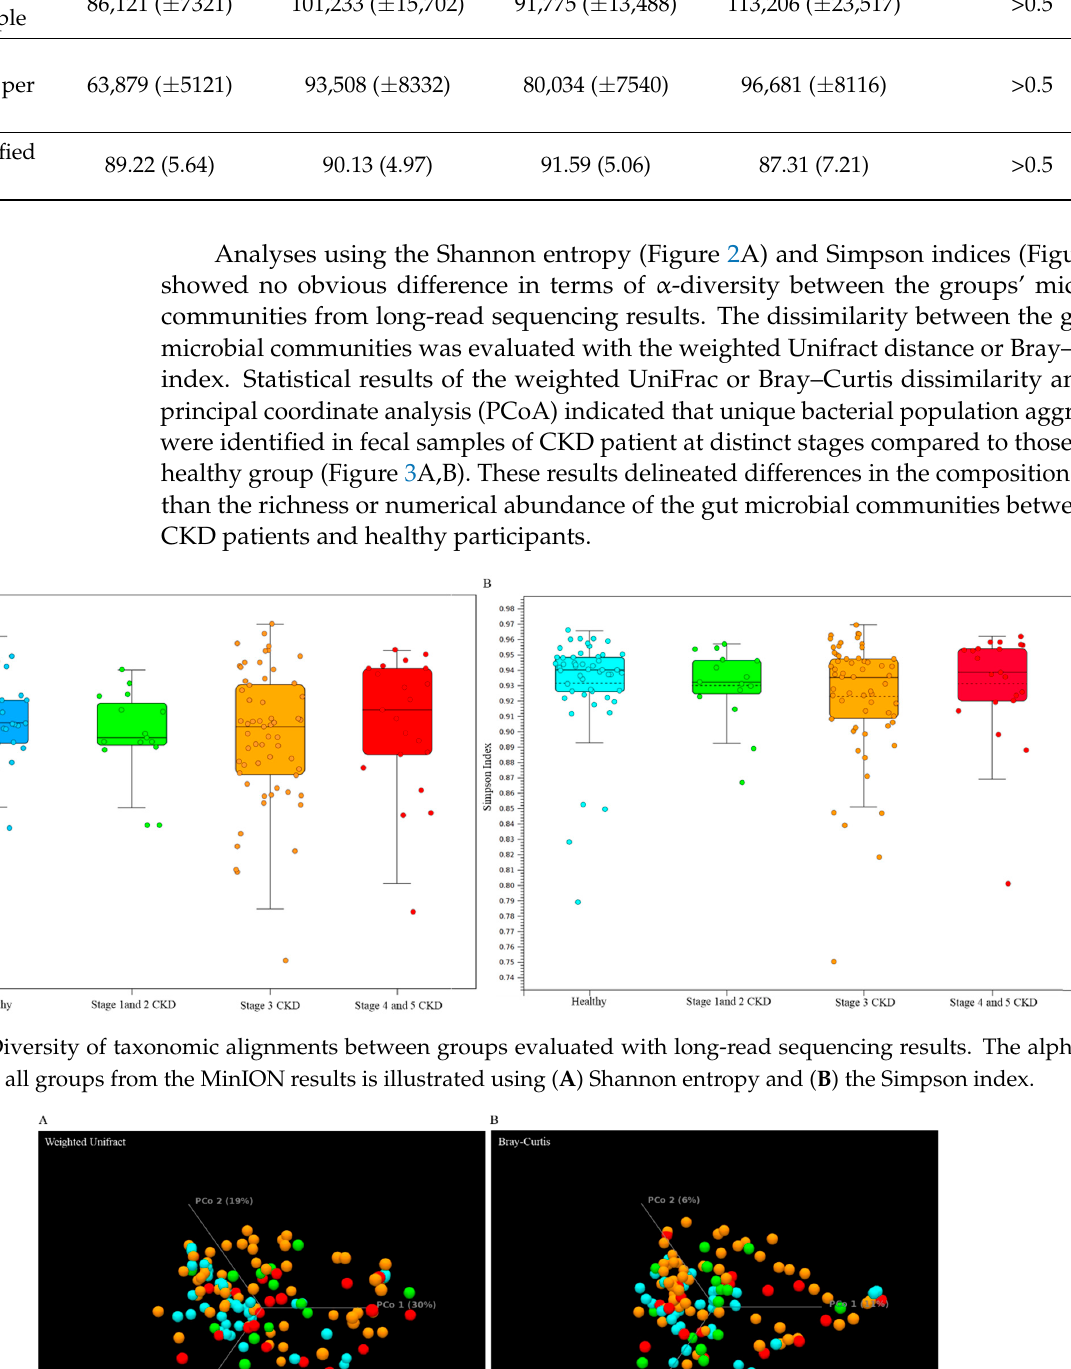
Table 2. Summary statistics of long-read sequencing results.